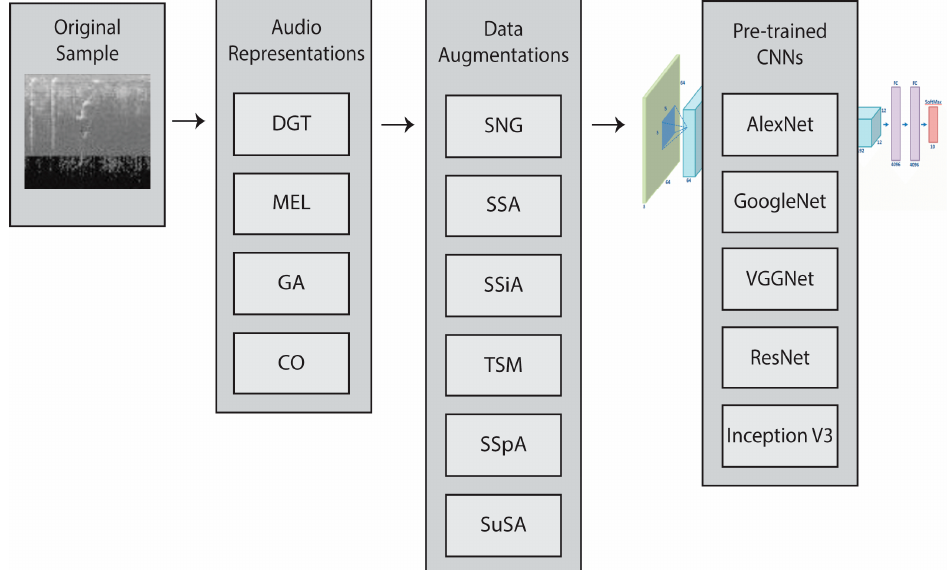
Figure 1. Proposed system. Many ensembles are generated by fine-tuning five pre-trained convolution neural networks (CNNs) separately on four possible audio representations combined with six main data augmentation methods. The best combinations are experimentally derived. The arrows indicate one possible combination of methods for building ensembles.